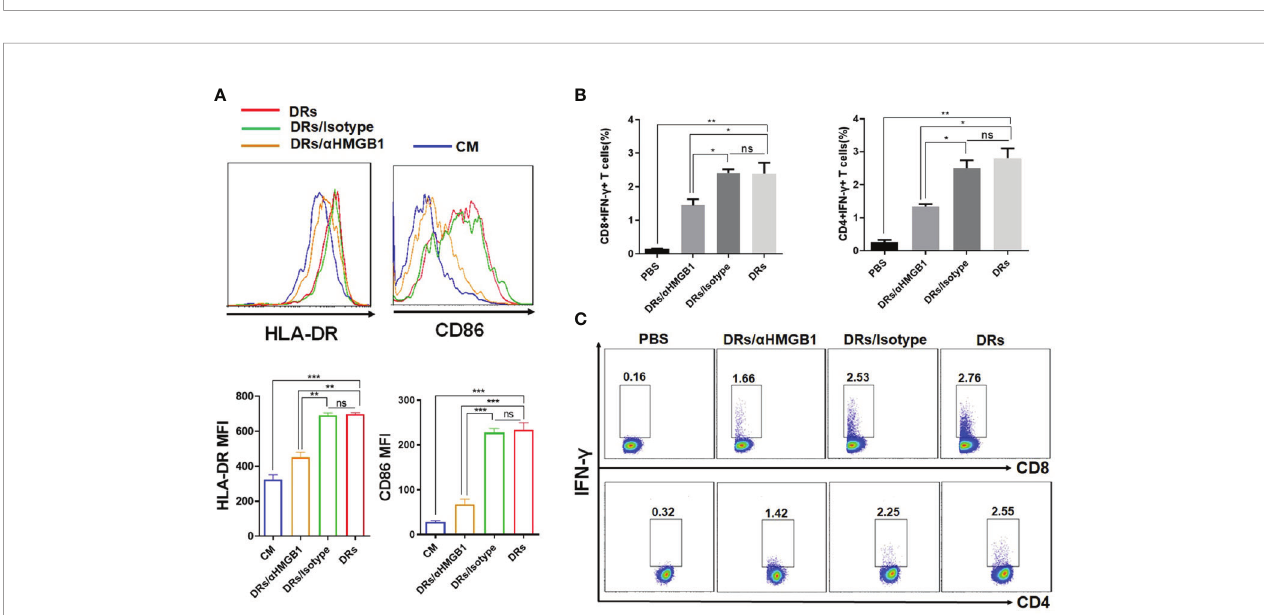
FIGURE 6 | HMGB1 on DRibbles was essential for human B cells activation. (A) HepG2.2.15 DRibbles were pretreated with anti-HMGB1 mAb or control isotype and then used to stimulate puri fi ed human B cells. After 72 h, the expression of HLA-DR and CD86 on human B cells were assessed by fl ow cytometry. (B) CMVpp65 + DRibbles pretreated with anti-HMGB1 mAb or control isotype were co-cultured with puri fi ed human B cells and then used to stimulate autologous puri fi ed human CD8 + T or CD4 + T cells. Intracellular cytokine staining (ICS) was employed to calculate the percentage of CD8 + IFN- g + T cells and CD4 + IFN- g + T cells. (C) The representative dot plot from one of the CMV positive donors was shown. MFI indicated mean fl uorescent intensity. Data are representative of three independent experiments with similar results from three different individuals. ns, P > 0.05, * p < 0.05, ** p < 0.01, *** p <